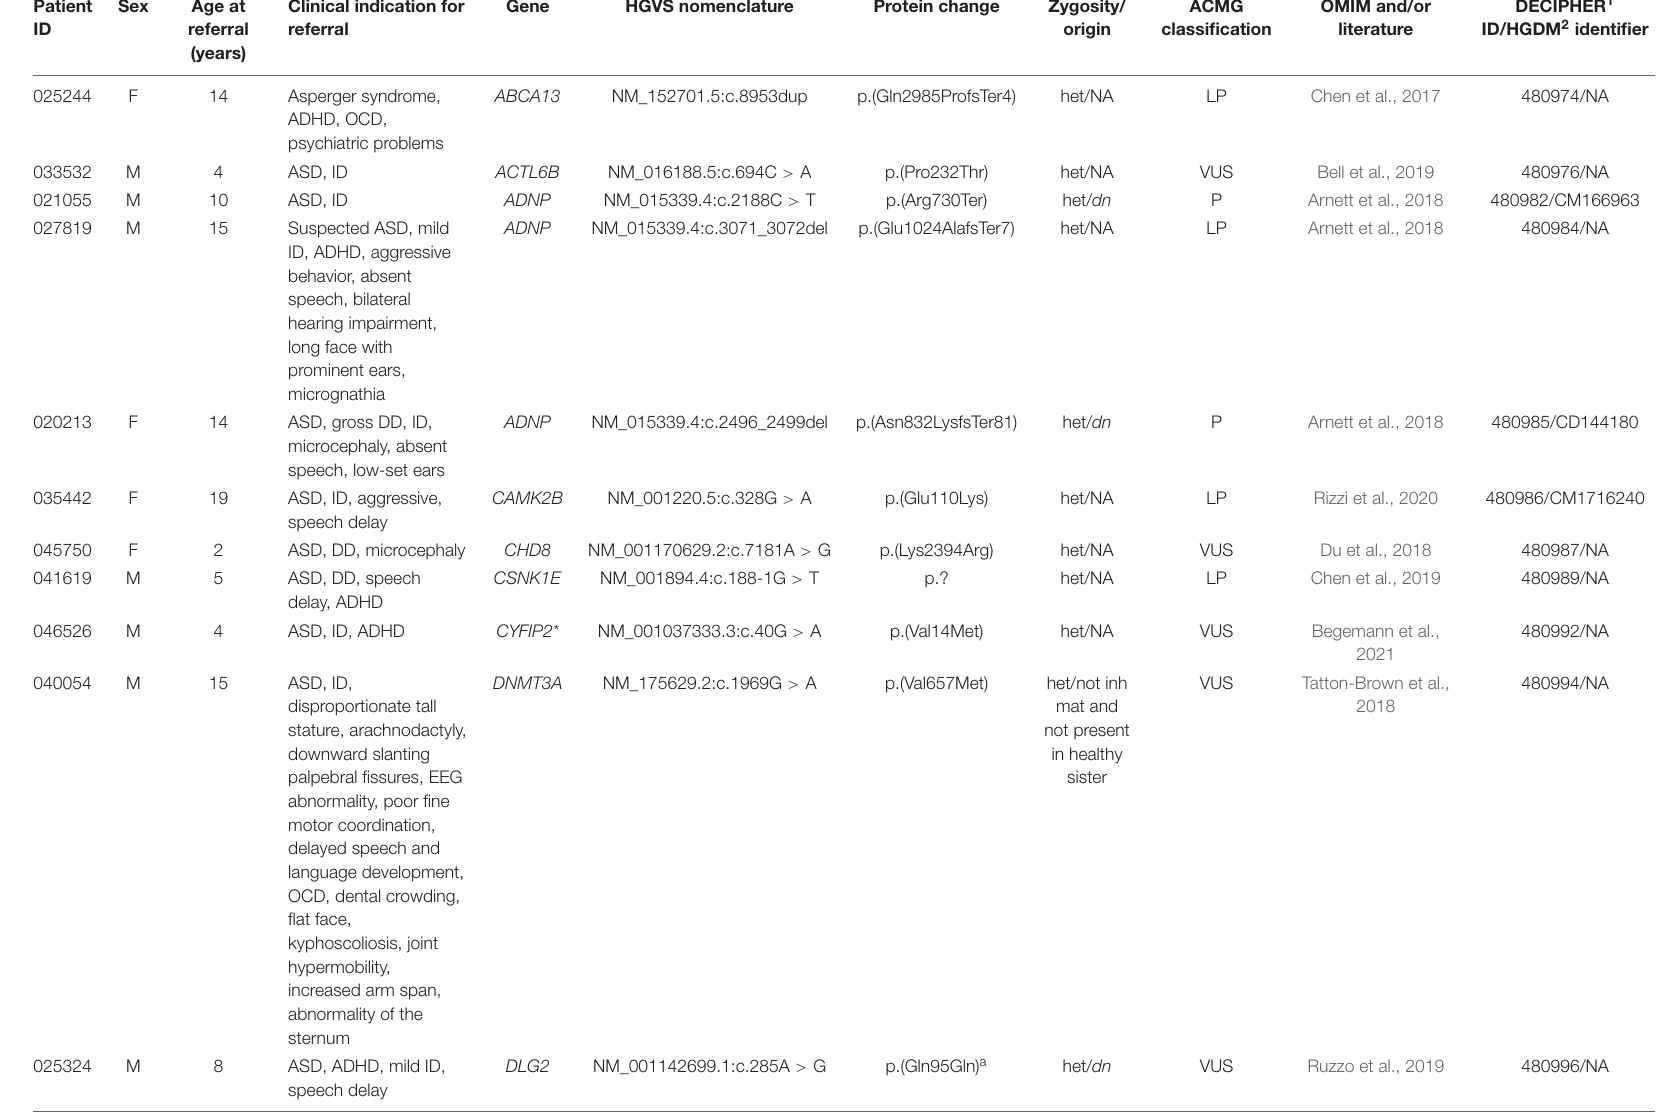
TABLE 2 | Description of patients clinical characteristics for molecular diagnostic referral and identified as pathogenic, likely pathogenic, and VUS variants in the genes. Patient